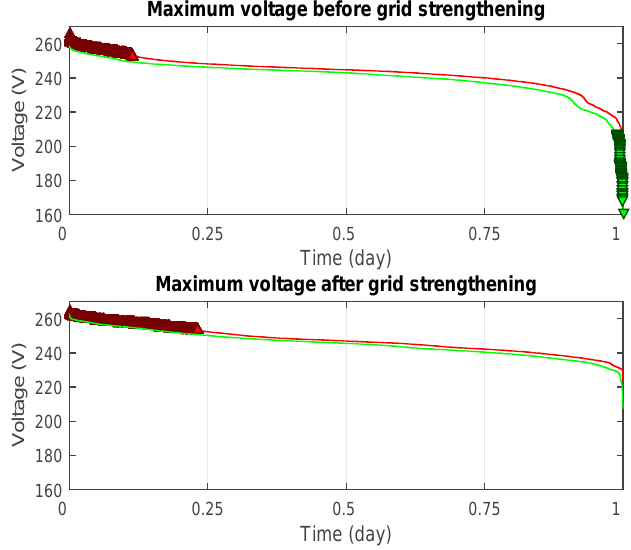
Figure 6. Voltage behavior before ( above ) and after ( below ) the grid strengthening during one day with the values sorted in descending order. The red line represents the maximum voltages and the green line represents the minimum voltages. Swells are marked with red upwards-pointing triangles and dips are marked with green downwards-pointing triangles.